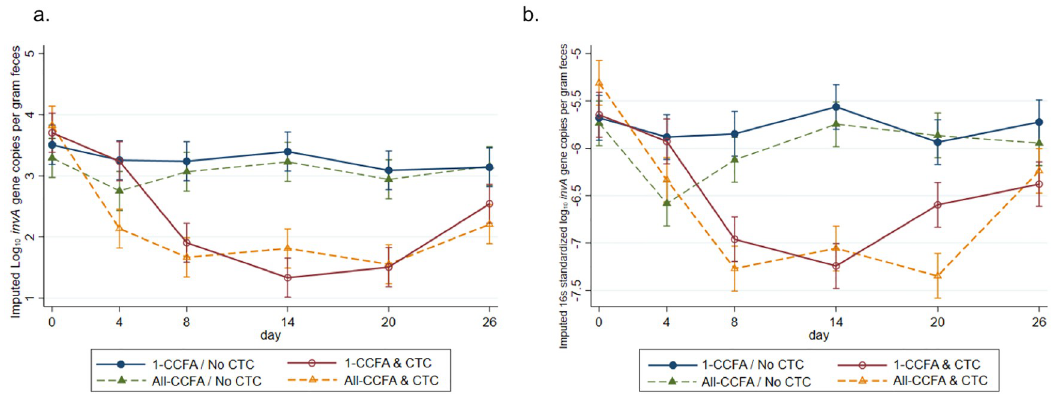
Fig 5. (a) Modeled marginal predictions with single imputed data for log 10 invA gene copies per gram feces by treatments and days with 95% CI. (b) Modeled marginal predictions with single imputed data for 16s standardized log 10 invA gene copies per gram feces by treatments and days with 95% CI. CCFA: ceftiofur crystalline-free acid, CTC: